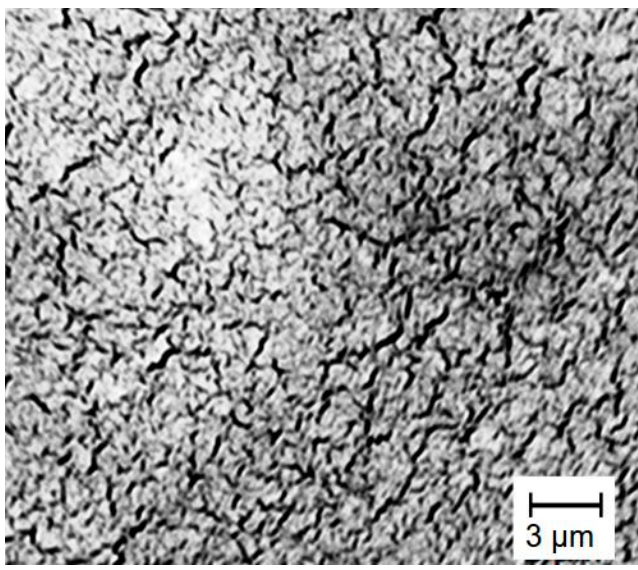
Figure 10. SEM image of sample S6.